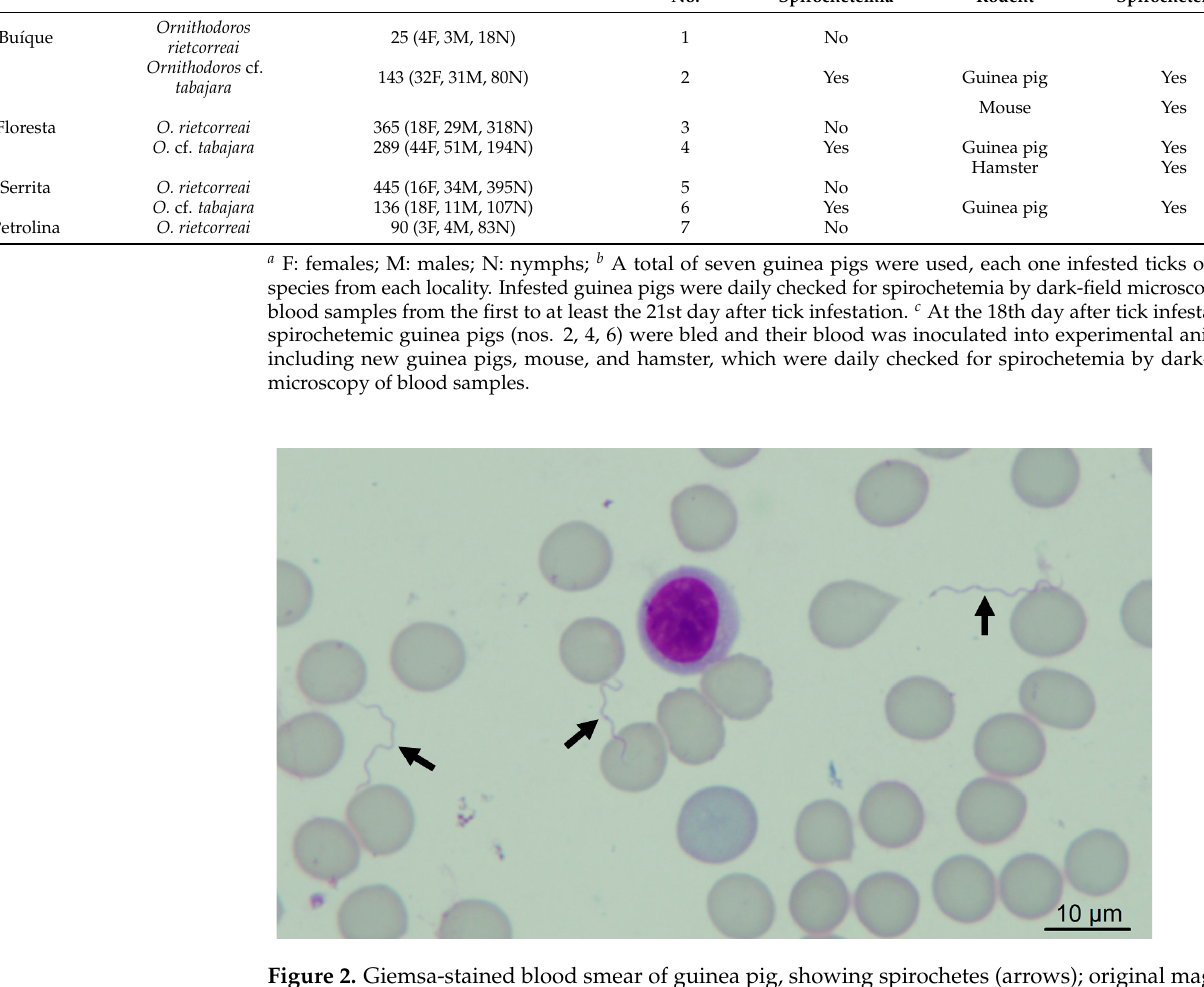
Figure 2. Giemsa-stained blood smear of guinea pig, showing spirochetes (arrows); original magnifi- cation: 1000 ×